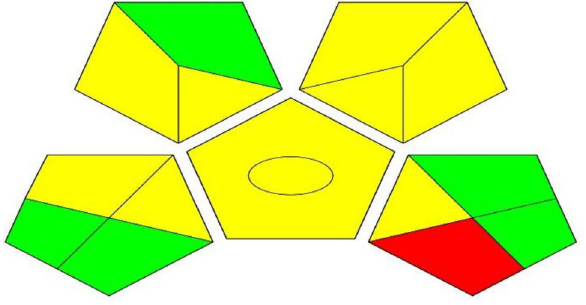
Figure 4. Green analytical procedure index pictogram symbol of the proposed TLC